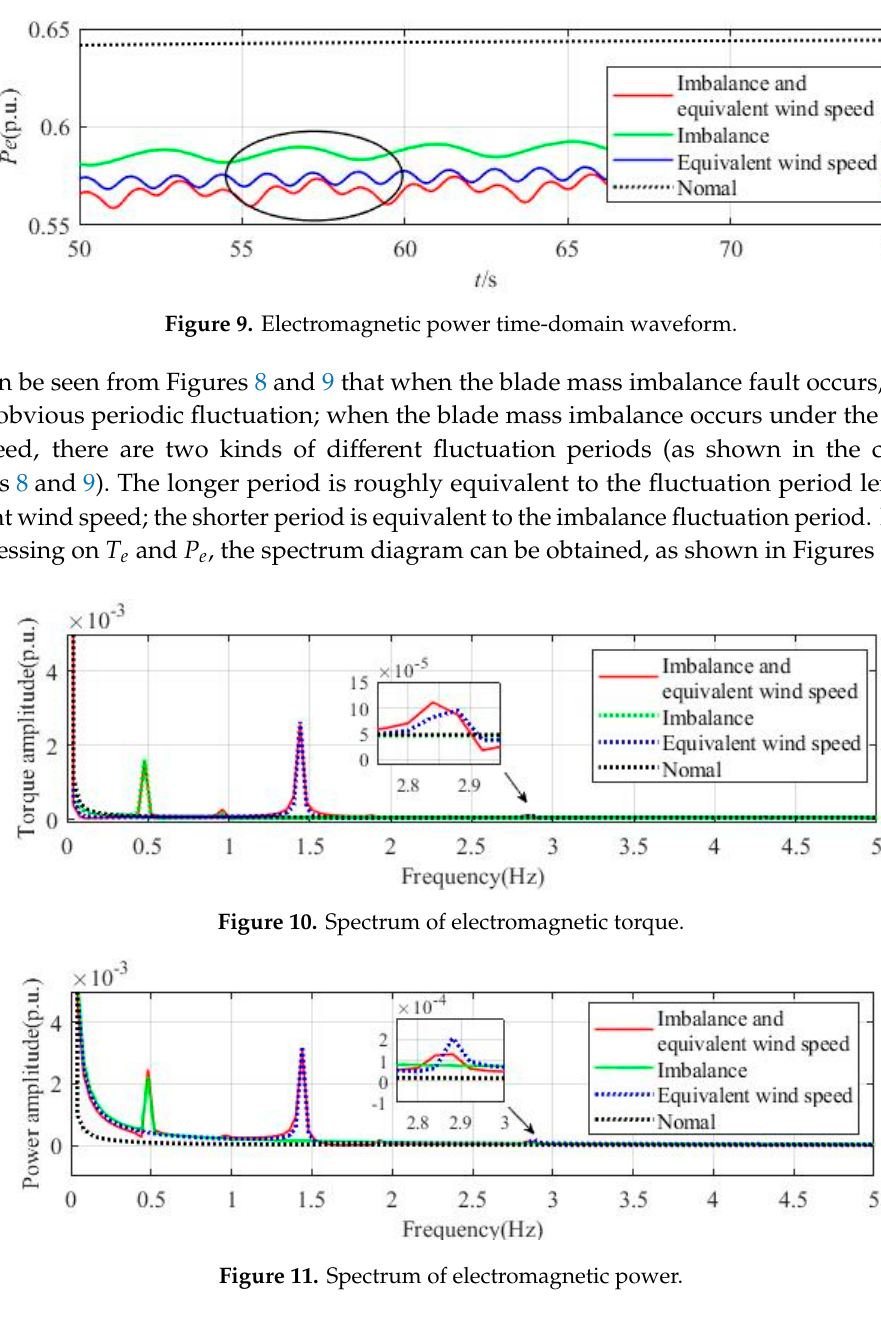
Figure 8. Electromagnetic torque time-domain waveform.